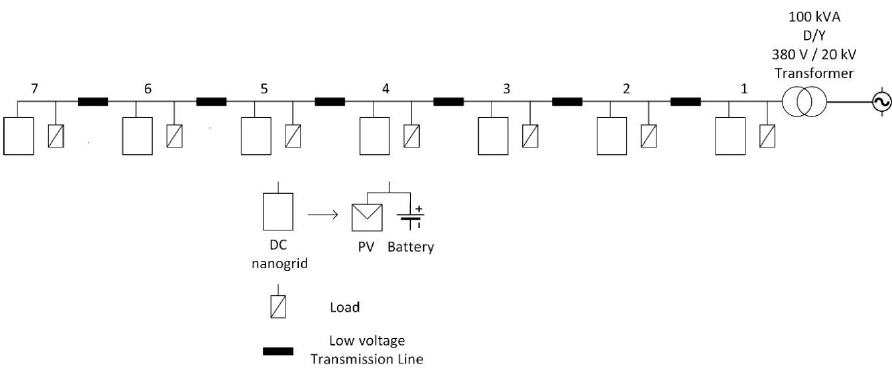
Figure 13. The understudy radial distribution power grid.